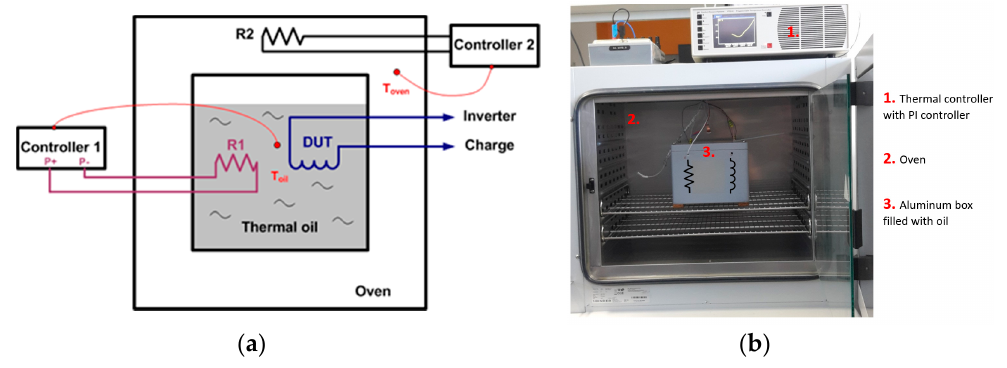
Figure 19. ( a ) Schematic and ( b ) picture of the inductor loss measurement bench.